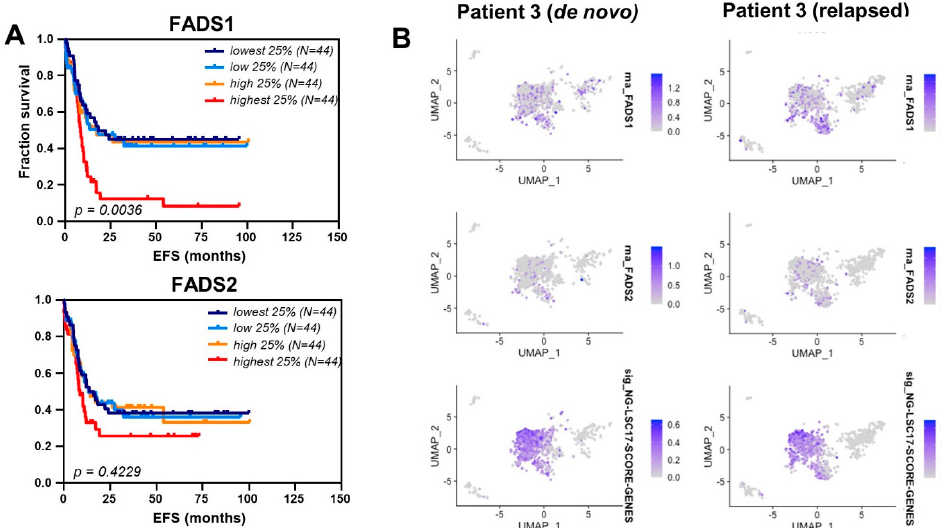
Figure 4. FADS1 and 2 contribute to AML pathogenesis and are expressed in the LSC compartment. ( A ) Fraction of survival of AML patients divided into 4 quartiles of FADS1 and FADS2 expression. Data mined from TCGA. ( B ) Single-cell RNAseq from the paired patient 3 de novo and relapsed samples. Top: Expression of FADS1. Middle: Expression of FADS2. Bottom: cells previously characterized in Ng, S. W., et al. (2016, Nature ), showing expression of a series of 17 stem cell markers (LSC17).